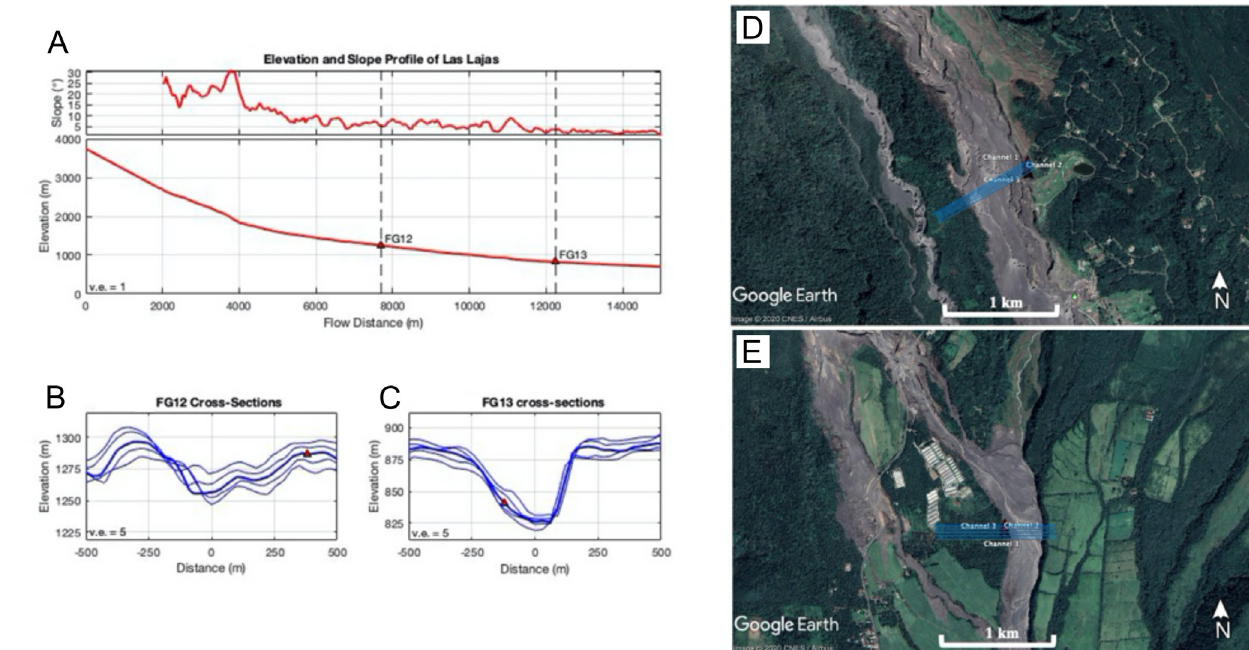
Figure 9: [A] Slope profile along Las Lajas drainage shows a slight change in slope angle from 5–8°at FG12 to approximately 2–4°at FG13. [B] and [C] Cross-sectional profiles with station locations (red triangles) correspond to NE-W and E-W slope profiles (blue lines) on Google Earth images ([D] and [E]). [D] and [E] Google Earth images from November 2018 taken by Maxar Technologies and CNES/